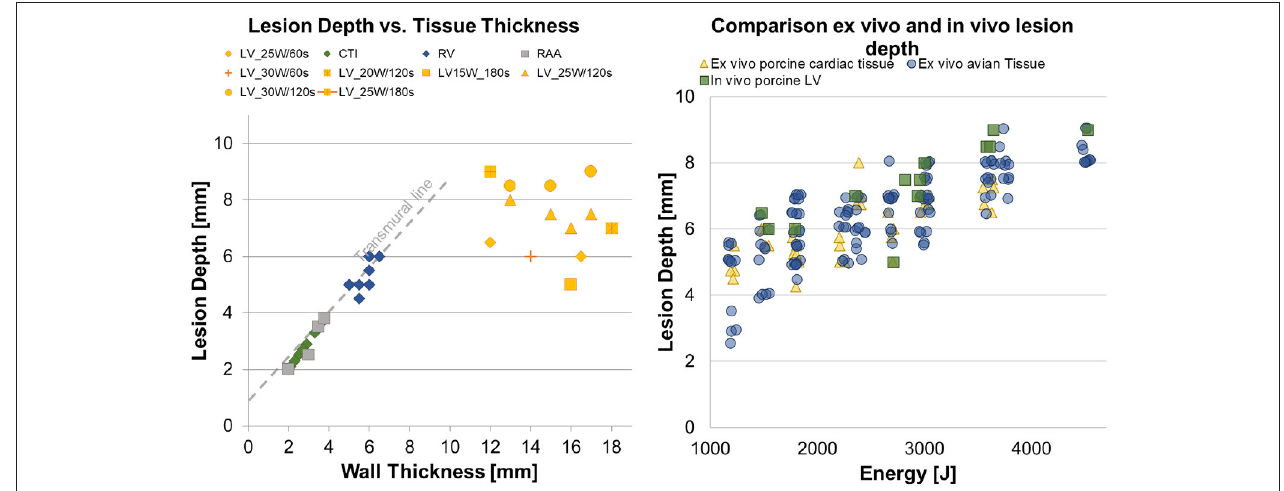
FIGURE 6 | (Left) Overview of the performed CTI and epicardial ventricle ablations, with a differentiation between transmural and non-transmural ablations. (Right) Three scatter plots, representing the in vitro avian tissue model, the in vitro porcine cardiac tissue model and the results from the in vivo study.